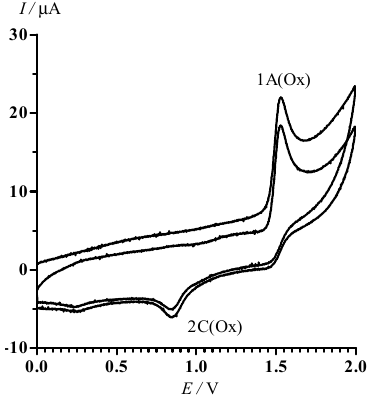
Figure 4. CV of 13 in MeCN in the range of potential sweep 0 < E < 2.0 V. The potential sweep rate was 100 mV·s –1 .